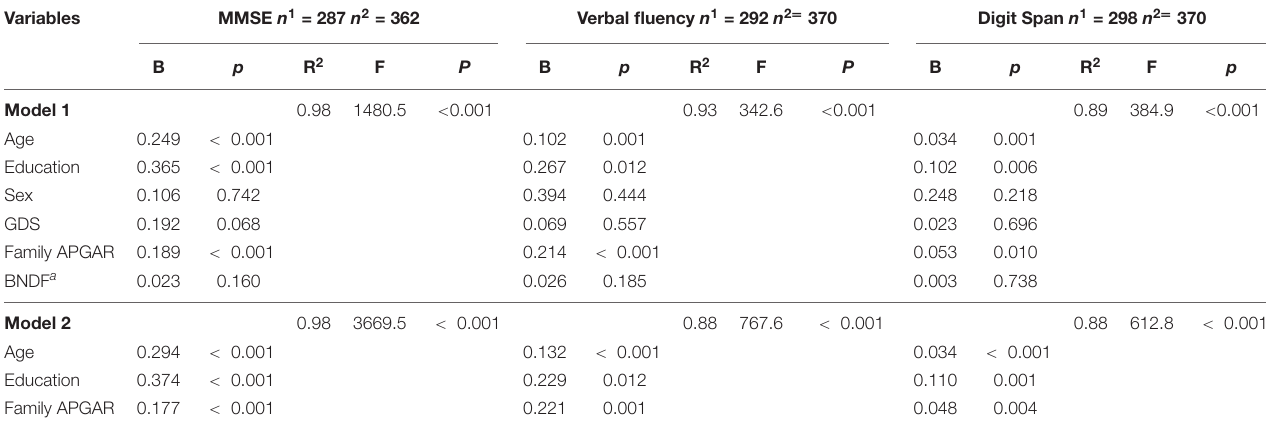
TABLE 4 | Multivariate regression coefficients between Family APGAR, BDNF and cognitive performance, adjusted for covariates.